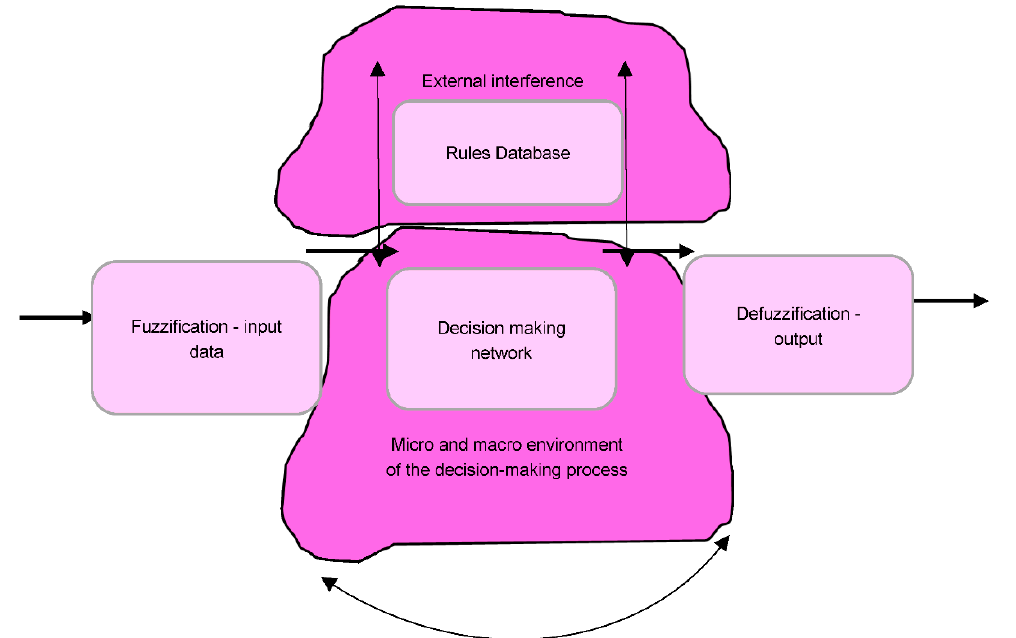
Figure 3. Model of a fuzzy decision